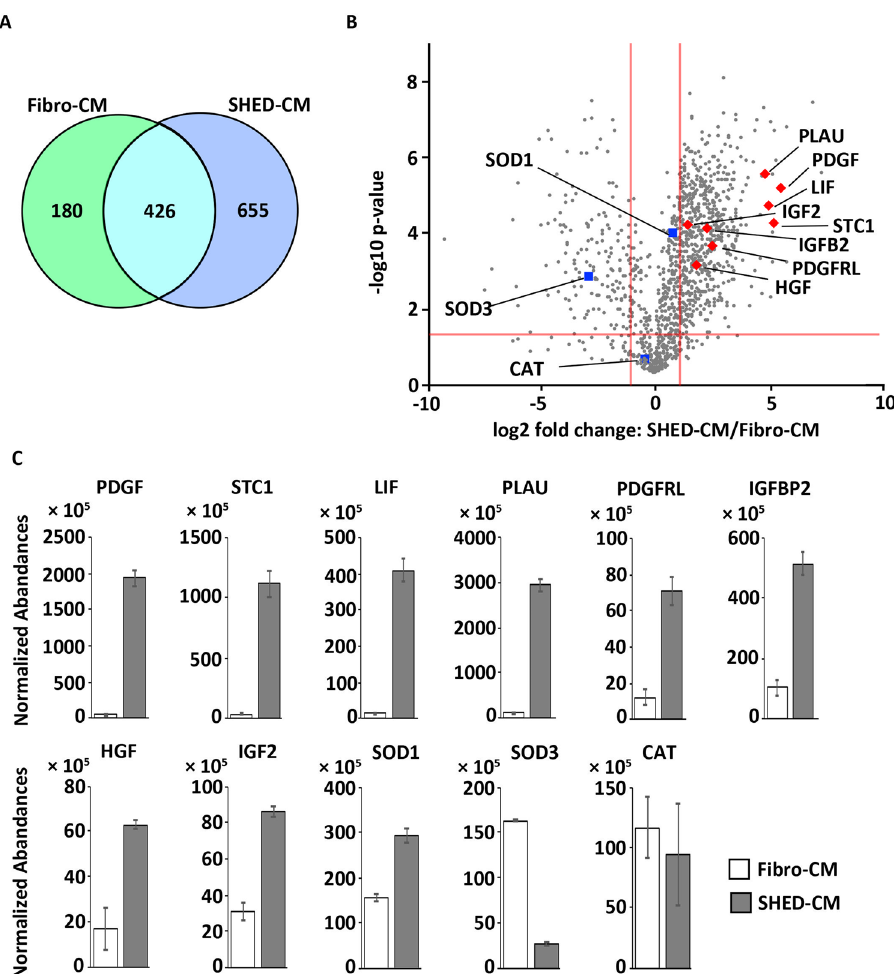
Figure 8. Secretome analysis of SHED-CM. ( A ) Venn diagram indicating a summary of the LC–MS/MS analysis of SHED-CM and Fibro-CM. ( B ) Volcano plot showing the differential protein profiles in SHED-CM and Fibro-CM. The x axis indicates the Log 2 -fold for the abundance ratio of the proteins identified in SHED-CM and Fibro-CM. The y axis indicates the negative log 10 for the p -value of the t-test results. The non-axial vertical lines denote the ± twofold change (SHED-CM/Fibro-CM), whereas the non-axial horizontal line denotes p = 0.05. ( C ) An accurate amount of protein in the samples used for proteomics was measured via label-free quantitative LC–MS/MS. The normalized abundance was calculated compared with that in the Fibro-CM. The scatter plot shows the individual data, and the bar graphs indicate the mean ± SD (n = 3). CM,